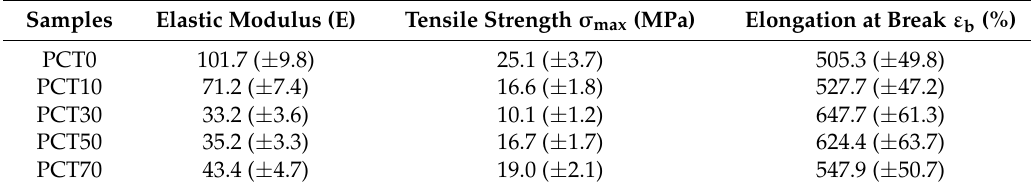
Figure 8. Tensile stress–strain curves of the (PBT-co-PCT)-b-PTMG copolymer. Table 6. The mechanical properties for the (PBT-co-PCT)-b-PTMG copolymers